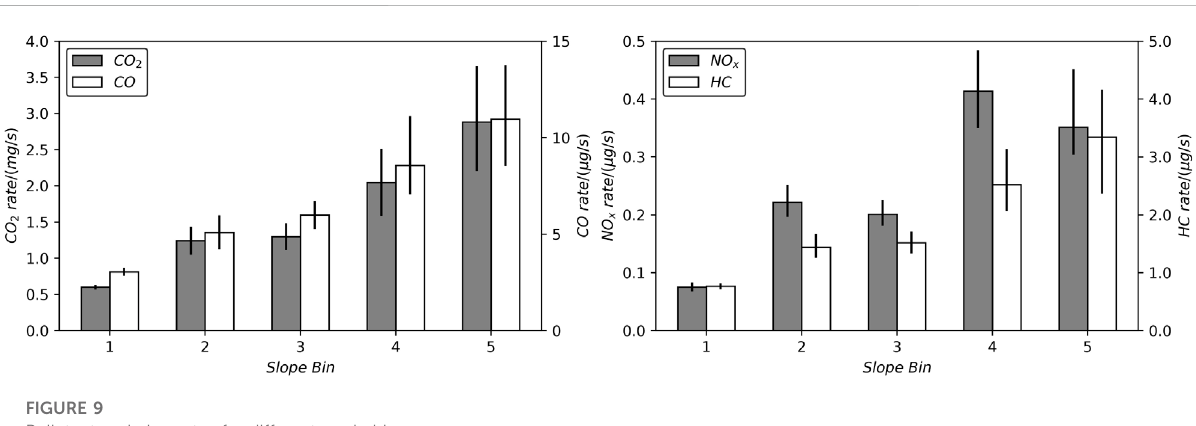
FIGURE 9 Pollutant emission rates for different grade bins.